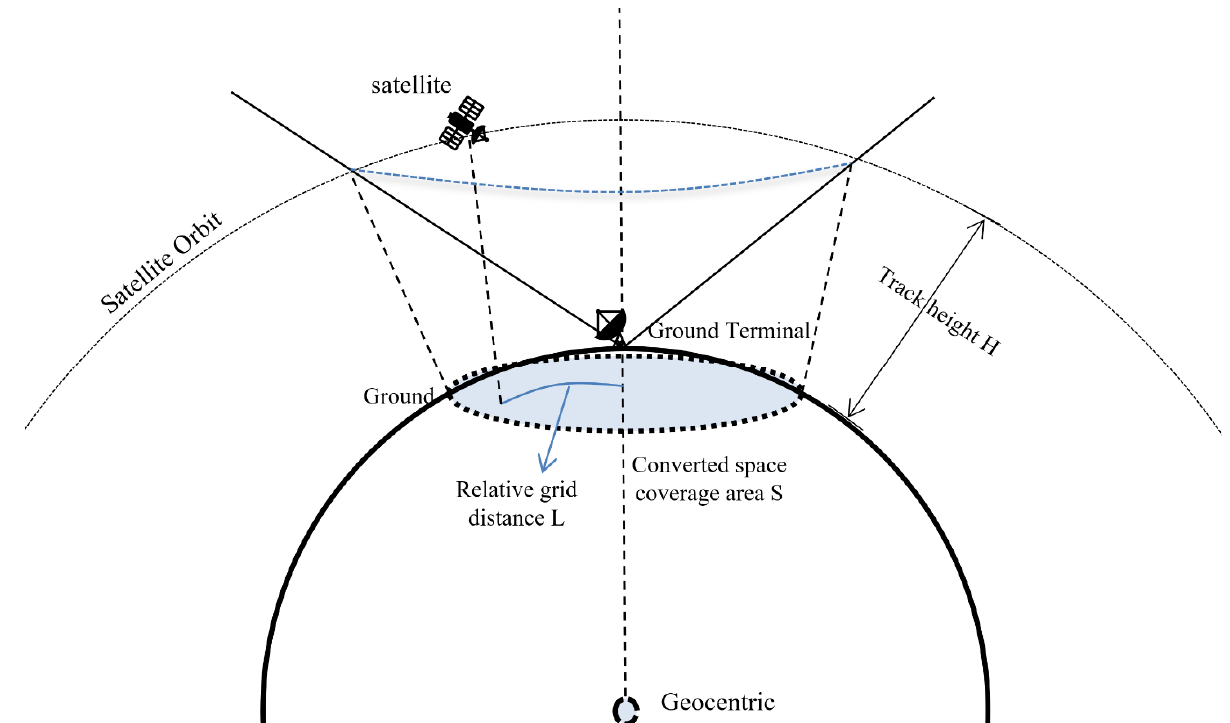
Figure 4. Simplified schematic of ground terminal satellite coverage area.